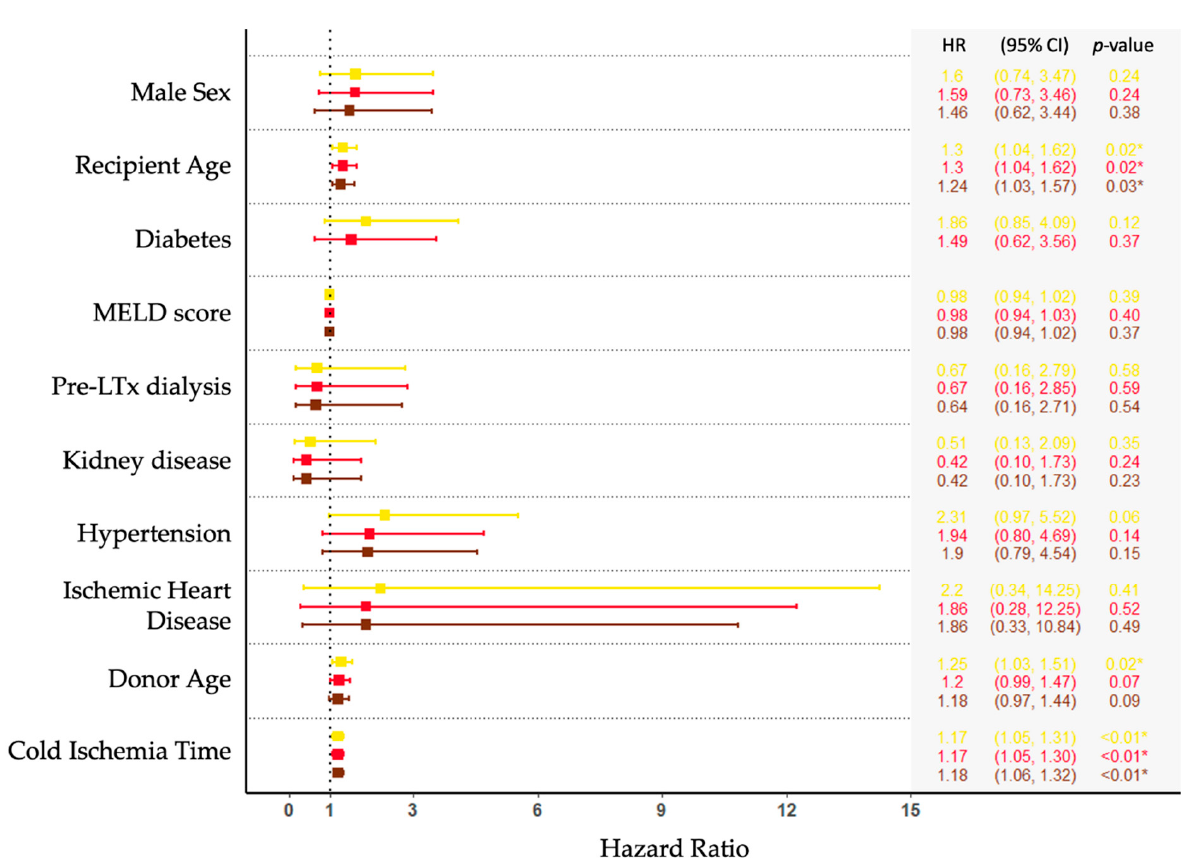
Figure 2. Cox hazard ratios of recipient- and graft-characteristics. Forest plots represent the unadjusted (yellow), adjusted for age and sex (red), and fully adjusted (brown) models. Note: One person may experience several bloodstream infections. Recipient Age, age at the time of transplantation, continuous variable measured in per 10 years older; MELD score, continuous variable measured in the value of Model for End-Stage Liver Disease; Donor Age, age at the time of graft removal, continuous variable measured in per 10 years older; Cold Ischemia Time, time between the chilling and removal of donor liver and the time of restored blood supply in recipient, continuous variable measured in hours. The asterisk (*) represents p <